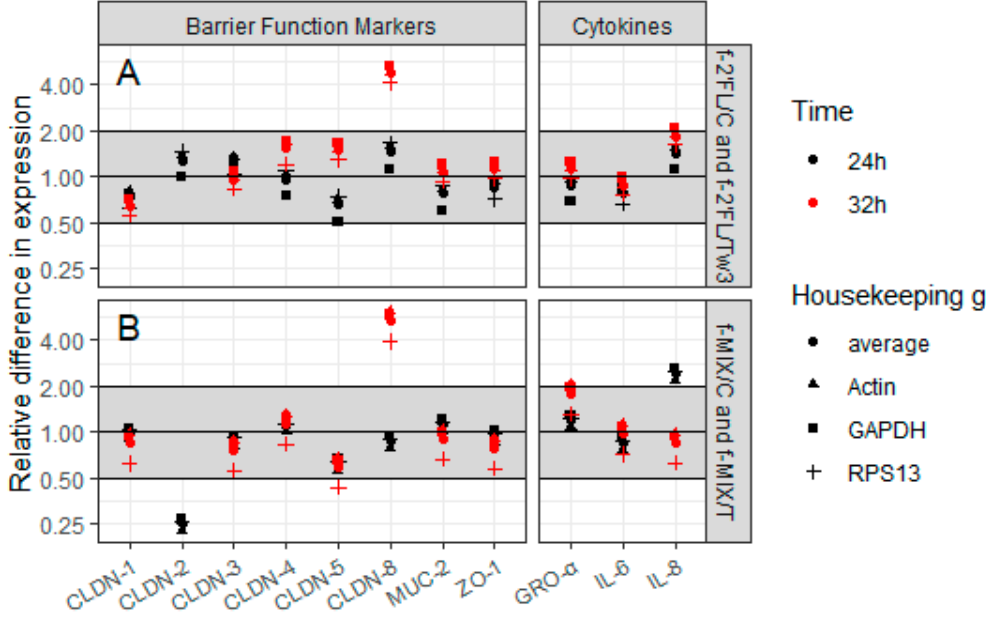
Figure 5. E ff ect of f-HMO treatment on gene expression of barrier function proteins and gene expression of cytokines of Caco2. The 2ˆ( − ∆∆ Ct) method data are shown for Caco2 cells grown on transwells that were treated with f-2’FL ( A ) or f-MIX ( B ) for 24 h (black) and 32 h (red). Actin, GAPDH, and RPS13 were used as reference genes to normalize the data. CLDN-2 was not expressed in the f-MIX samples at 32 h time point.